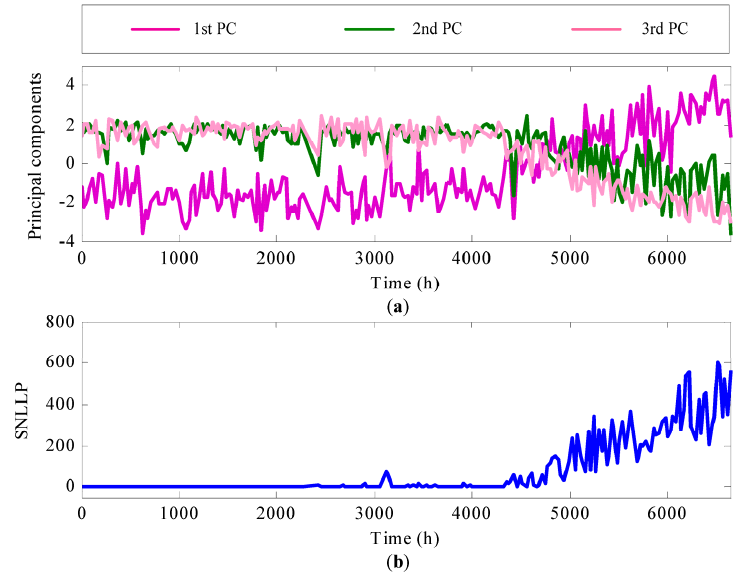
Figure 11. ( a ) the dimensionality reduction result by OLPP; ( b ) SNLLP health indicator.